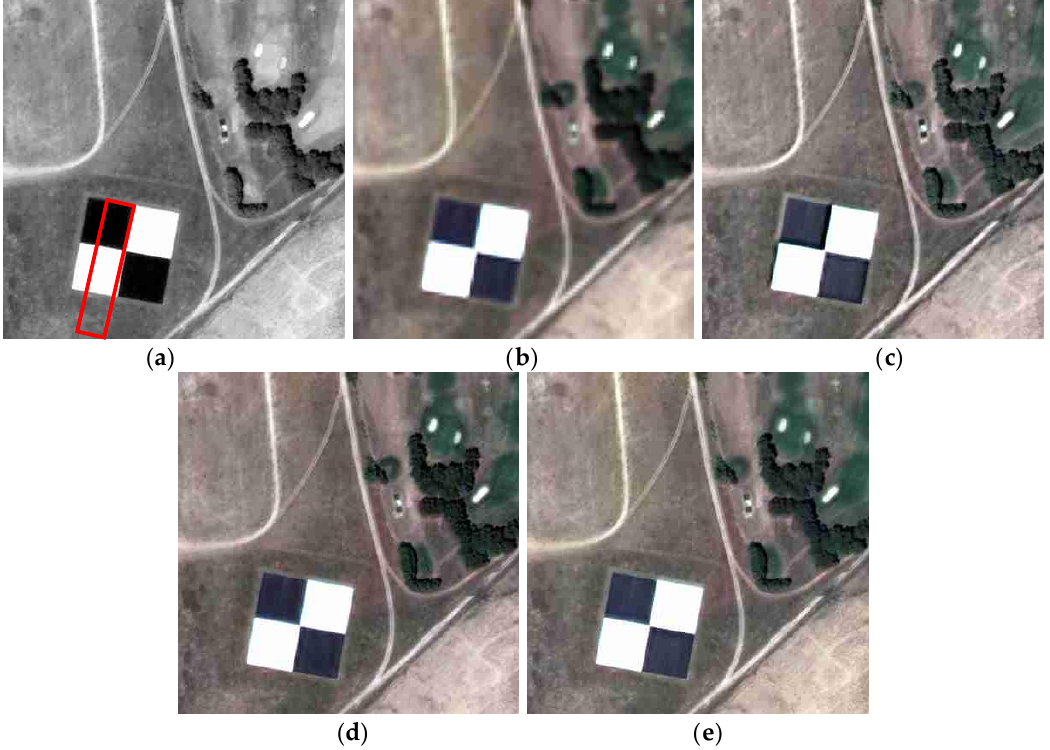
Figure 6. The details of the edge target according to each algorithm in the Salon region: ( a ) panchromatic image; ( b ) resized multispectral image; ( c ) image pansharpened by the MTF-GLP; ( d ) image pansharpened by the GSA; ( e ) image pansharpened by the GFNDVI.